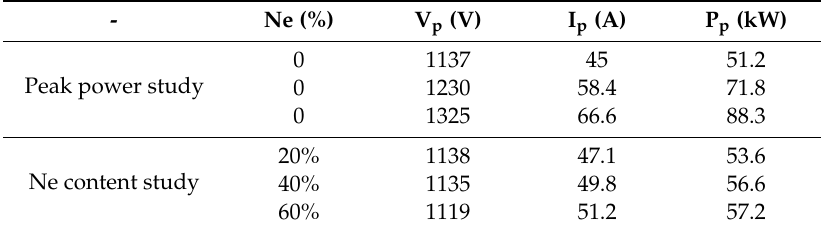
Table 3. Experimental conditions used for the flat probe substrate current density (SCD) measurements.